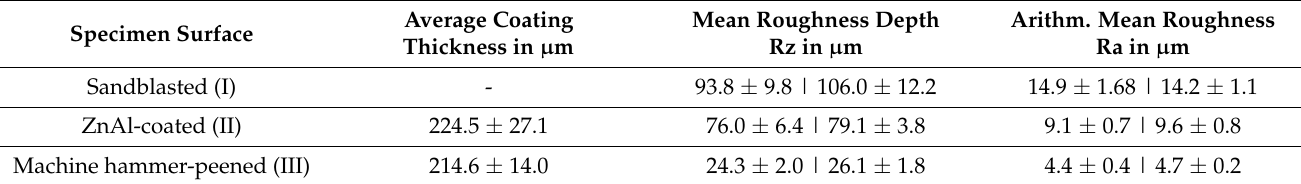
Figure 6. Polished cross-section of ZnAl-coated (II) specimen as ( a ) overview and ( b ) detail and of the MHP post-treated (III) specimen as ( c ) overview and ( d ) detail. Table 4. Average coating thickness of all measurements and roughness values in gauge length: